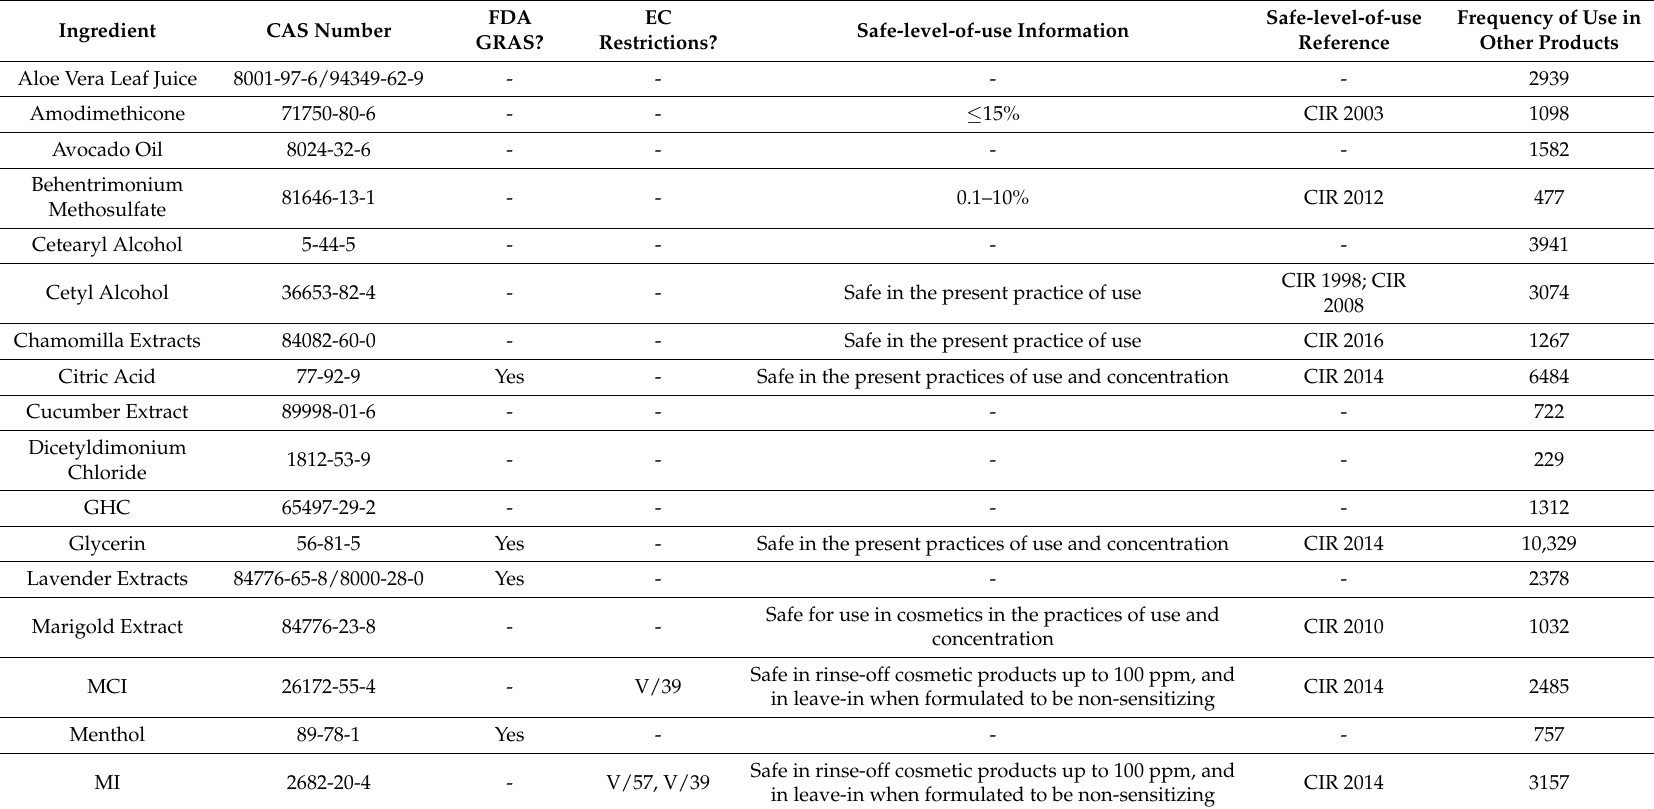
Table 1. Ingredients identified from on-market hair cleansing